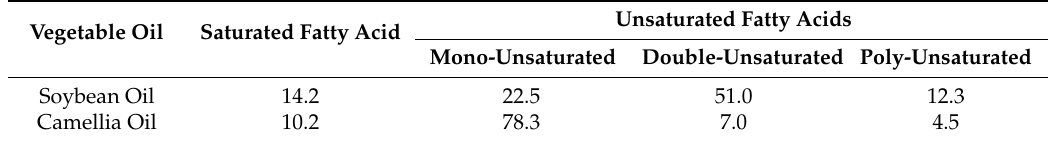
Table 10. Fatty acid content of soybean oil and camellia oil (%).